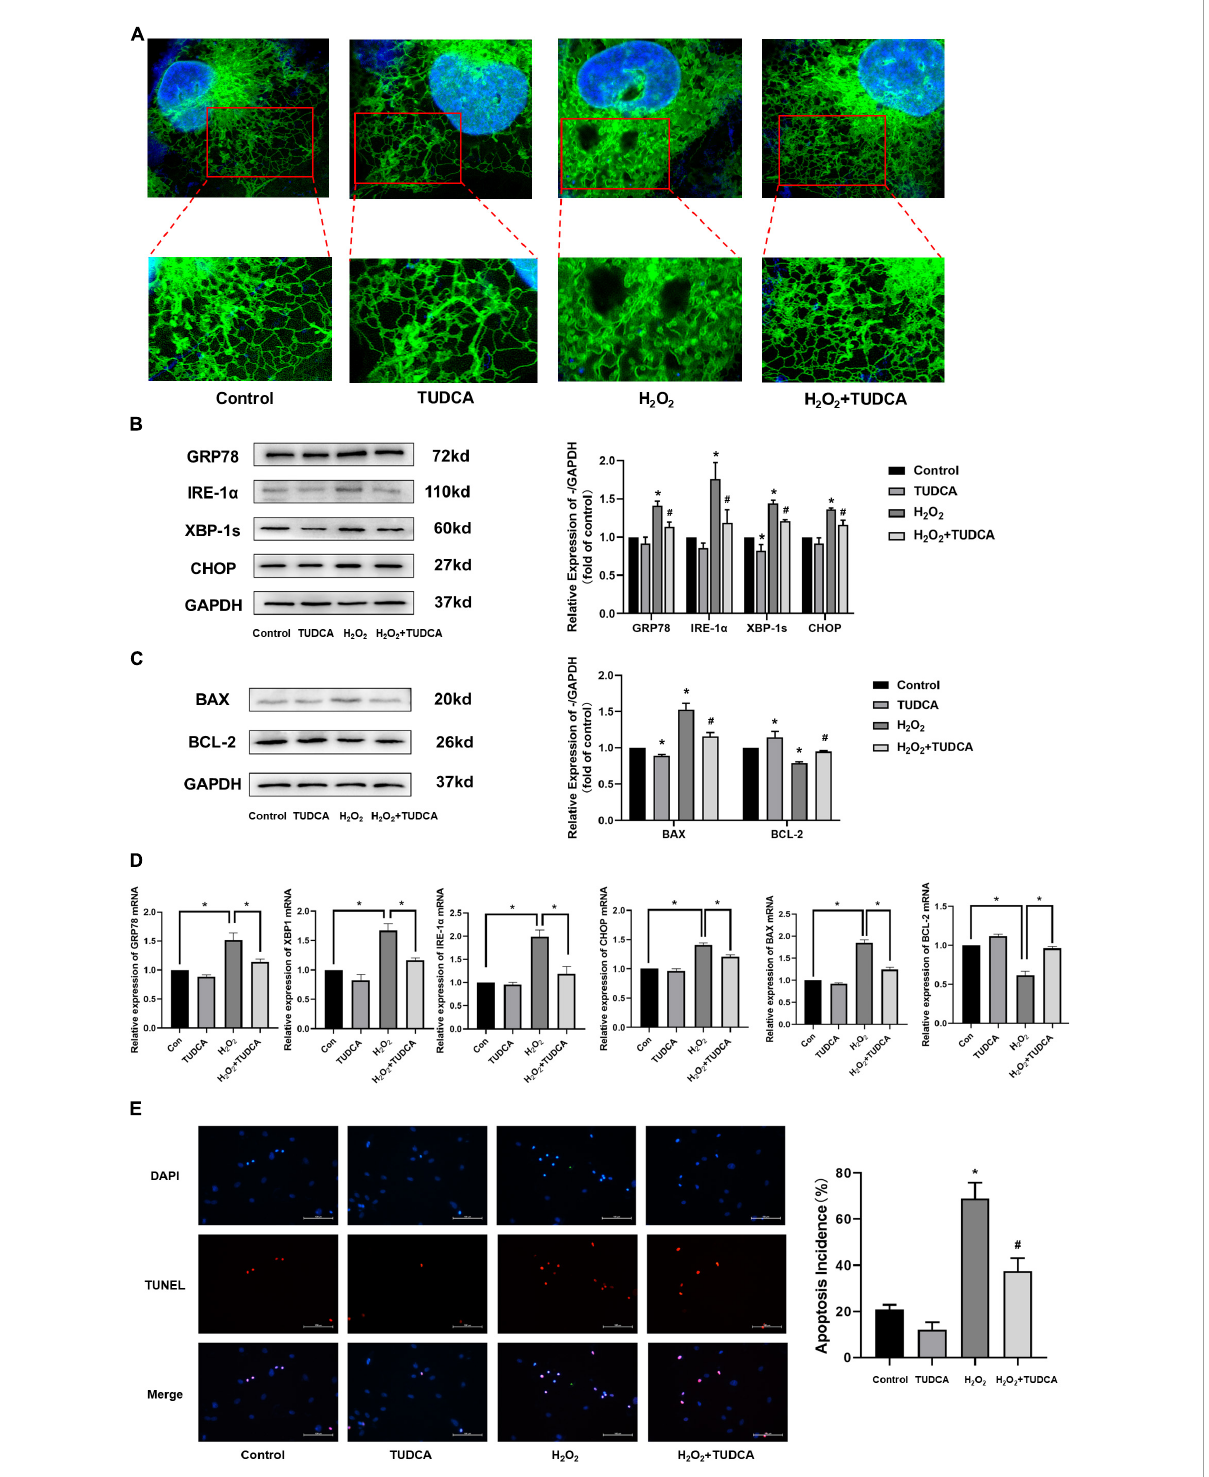
FIGURE4 Tauroursodeoxycholic acid (TUDCA) relieves endoplasmic reticulum stress (ERS) and reduces level of apoptosis in HUVECs. (A) Representative diagram of ER tracker, blue represents the nucleus and green represents the ER. (B) Western blotting was employed to quantitate the expression levels of ER stress marker GRP78, IRE-1 α , XBP-1s, and CHOP. (* P < 0.05 vs. control group, n = 3; # P < 0.05 vs. H 2 O 2 group, n = 3). (C) Western blotting was employed to quantitate the expression levels of BAX, BCL-2. (* P < 0.05 vs. control group, n = 3; # P < 0.05 vs. H 2 O 2 group, n = 3). (D) mRNA expression of GRP78, XBP-1s, IRE-1 α , CHOP, BAX, BCL-2. (E) Effects of TUDCA on H 2 O 2 -induced apoptosis of HUVECs, as detected by TUNEL apoptosis detection. (* P < 0.05 vs. control group, n = 3; # P < 0.05 vs. H 2 O 2 group, n =